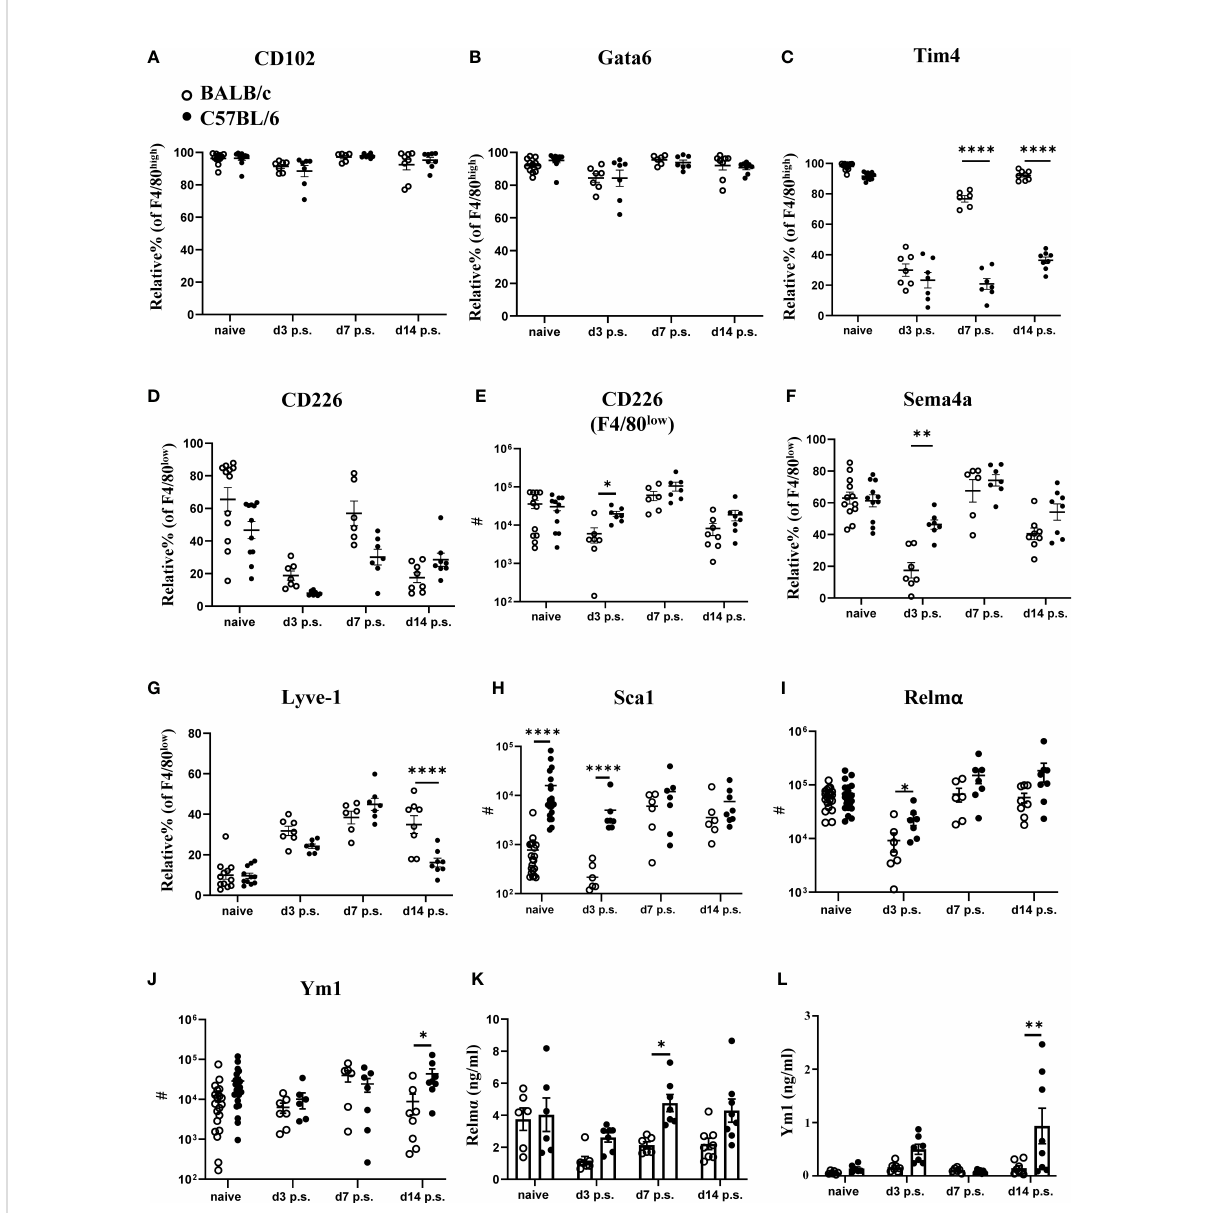
FIGURE 2 Peritoneal macrophage markers and cytokine pro fi les post-surgery in BALB/c mice were altered compared with C57BL/6 mice. Relative % of CD102+ (A) , Gata6+ (B) , and Tim4+ (C) of F4/80 high population. Relative % and total cell number of CD226+ F4/80 low ( D, E , respectively). Relative % of Sema4a+ (F) and Lyve1+ (G) of F4/80 low macrophage population. Total cell number of Sca1+ (H) , Relm a + (I) , and Ym1+ (J) in myeloid cells (CD11b+lin-Ly6C- cells) by fl ow cytometry. Peritoneal lavage levels for Relm a (K) and Ym1 (L) by ELISA. Data shows mean ± SEM, pooled from 6 separate experiments for naïve or 2 separate experiments for day 3, 7, and 14 p.s., n= 6-20 mice/group; * P <0.05, ** P <0.01, **** P< 0.0001, ANOVA with Tukey ’ s multiple comparison